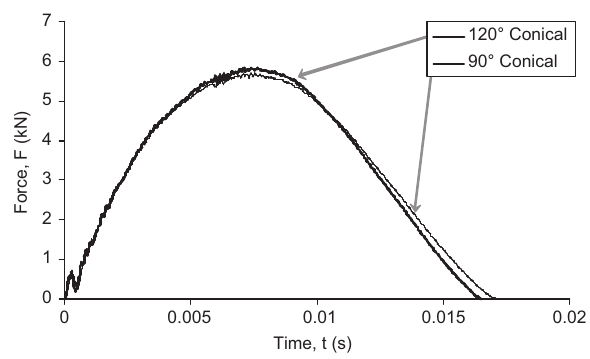
Figure 4 Force - time histories from the tests realized by conical impactors.